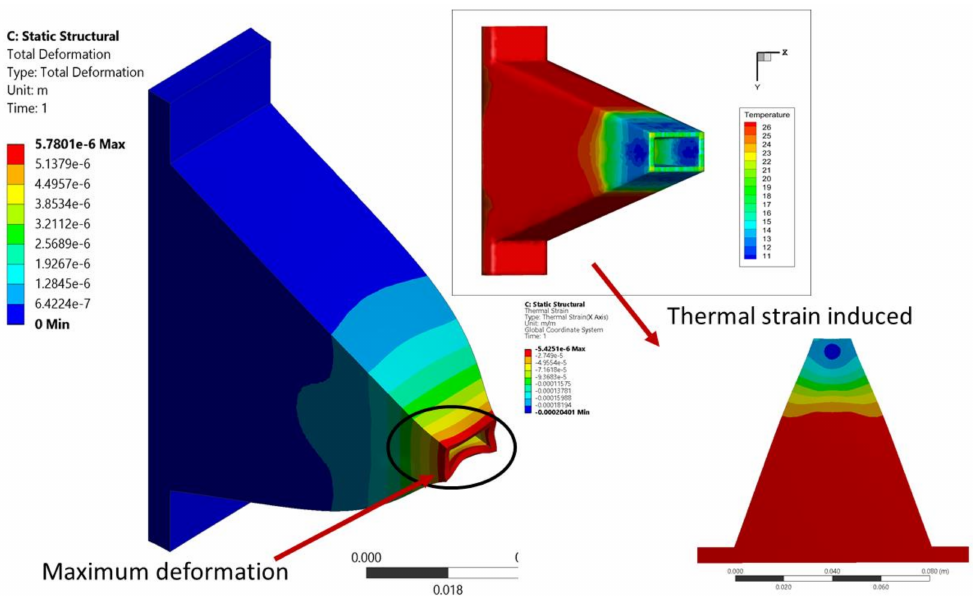
Figure 11. Total deformation (exaggerated 3 × for visualization) and thermal strain in improved design.